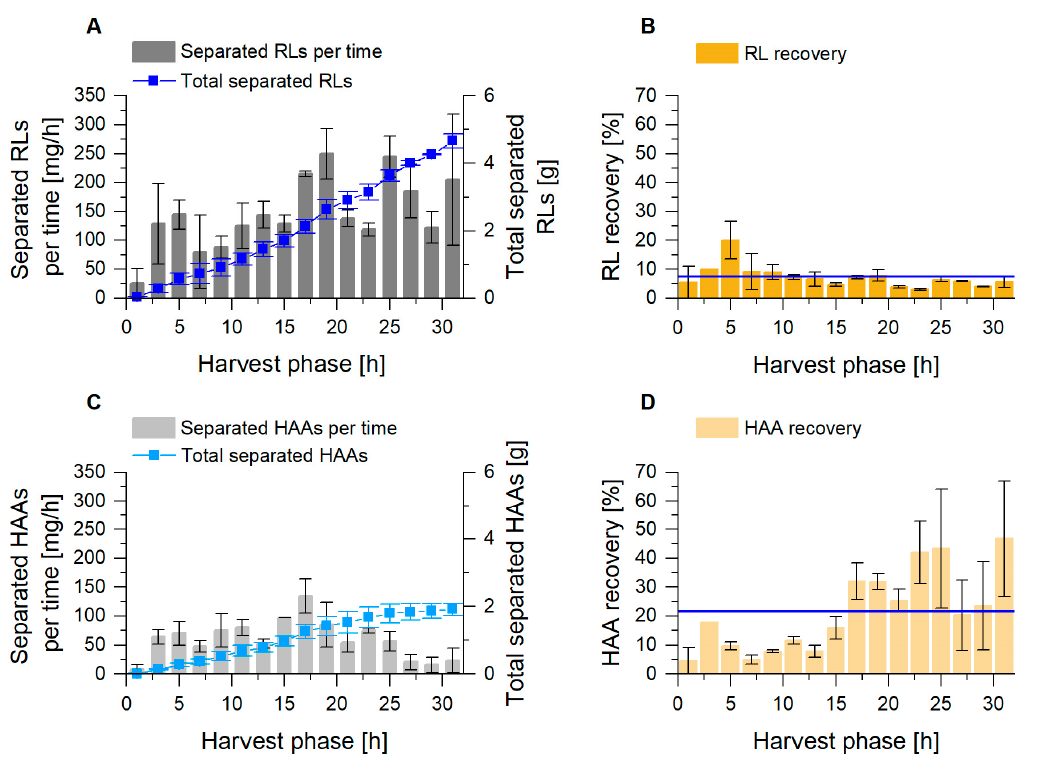
Figure 5. Foam fractionation performance for RL ( A ,B) and HAA ( C , D ) separation in the external foam fractionation column. ( A , C ) Separated mass flow of surfactant for every 2 h (gray columns) and the total mass of separated product (blue) during harvest phase. ( B , D ) Product recovery R P for every 2 h during harvest phase, with the mean value as blue line. The error bars indicate the deviation from the mean of two biological replicates.